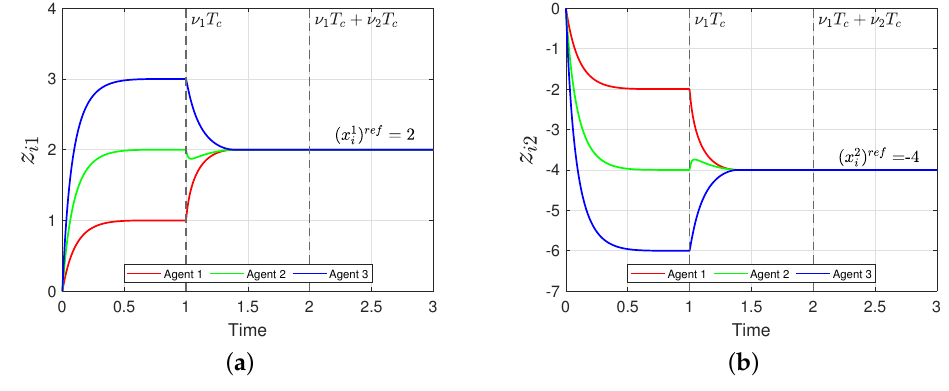
Figure 3. Response curves for the outputs of distributed optimal signal generator. ( a ) z i 1 ( b ) z i 2